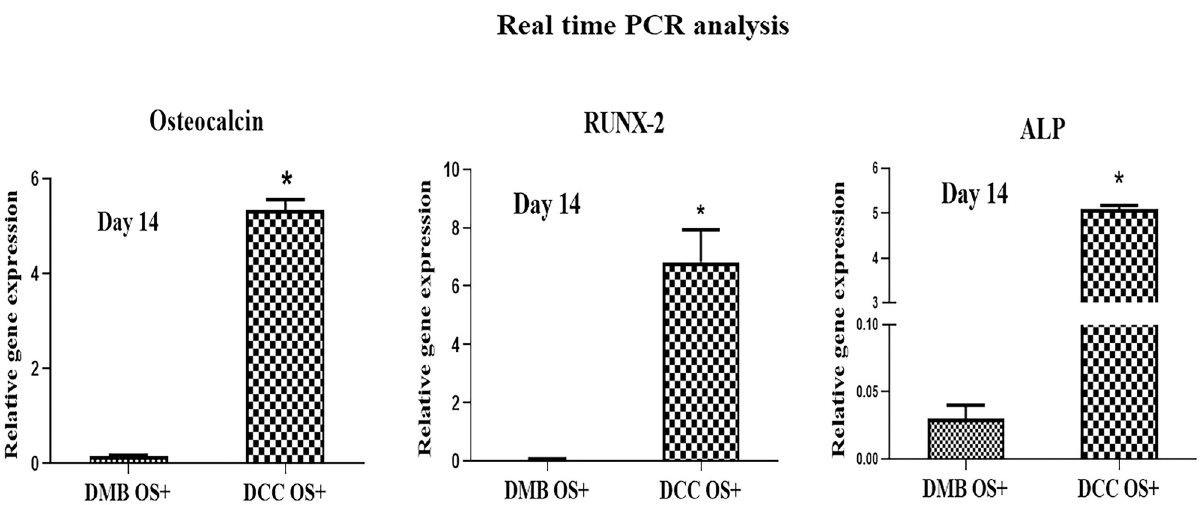
Fig 10. Gene expression during mineralization of human osteoblast cells grown on DMB and DCC scaffolds in osteogenic medium on day 14. The expression of genes was analyzed by real-time PCR. GAPDH expression was used as an internal control (n = 3).